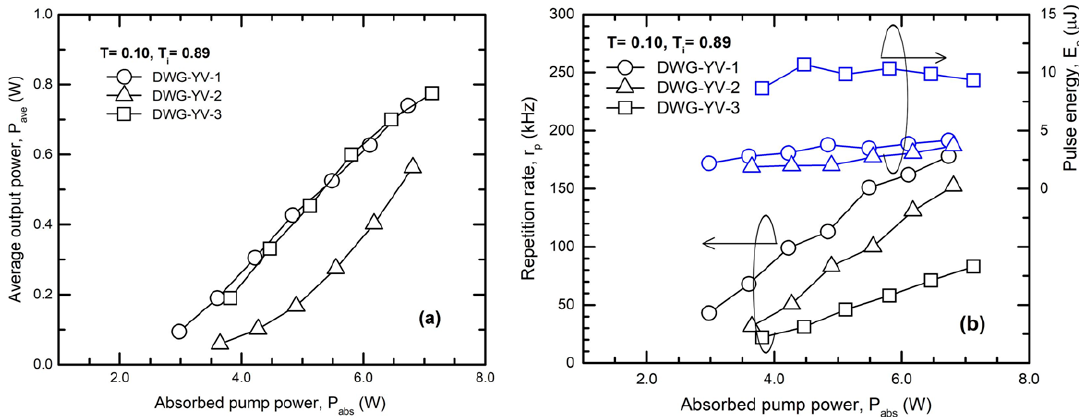
Figure 6. Q-switch operation for the waveguides inscribed in Nd:YVO 4 : ( a ) Average power, P ave ; ( b ) laser pulse repetition rate, r p and pulse energy, E p . OCM with T = 0.10 and Cr 4+ :YAG with T i = 0.89.